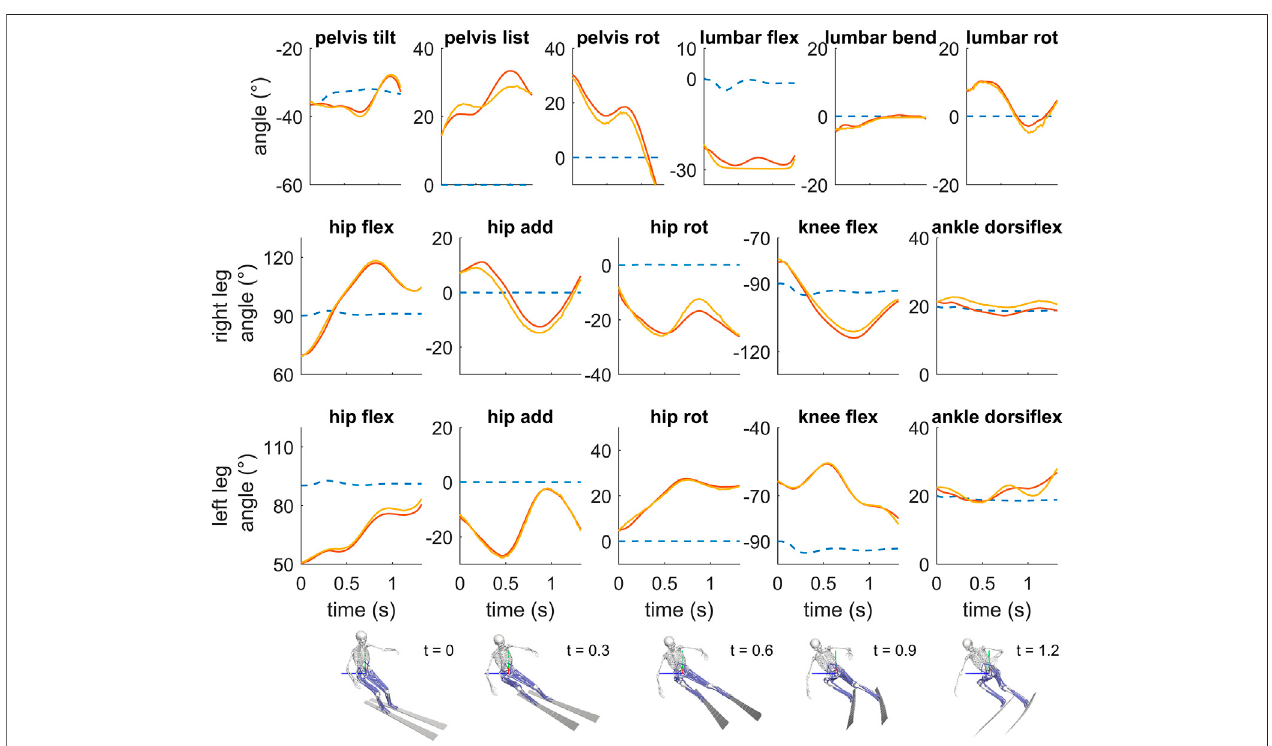
FIGURE 2 | Comparison of the optimized kinematics of the skier (red) during the turning simulation and the corresponding measured kinematic data (yellow). Kinematic data refer to the orientation of the pelvis (tilt, list, rotation) and the joint angles at the lumbar joint ( fl exion, lateral bending, rotation), hip joint ( fl exion, adduction, internal rotation), knee joint ( fl exion) and ankle joint (dorsi fl exion). The blue dotted lines represent the kinematics of a straight schussing maneuver, which was used as initial guess in the optimization